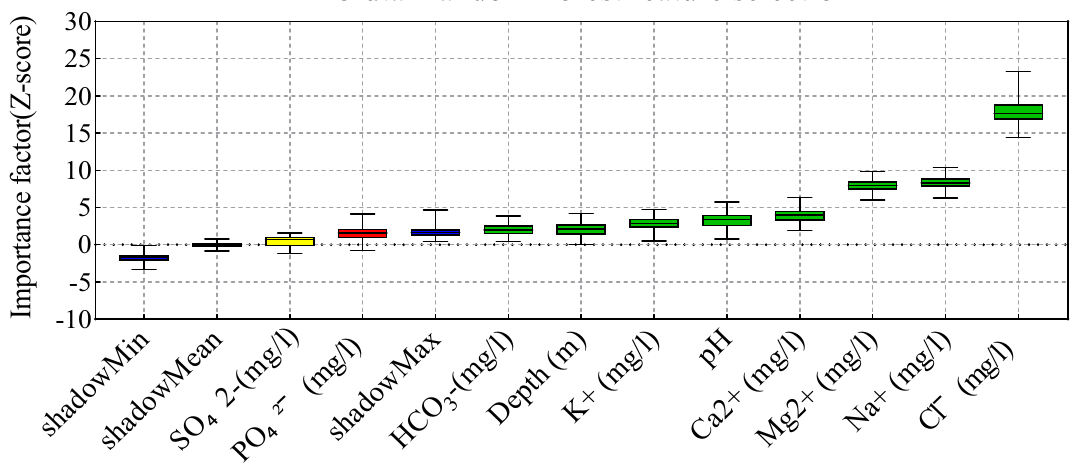
Figure 5. Feature selecting process using the Boruta-Random Forest method based on Z-score for all candidate input